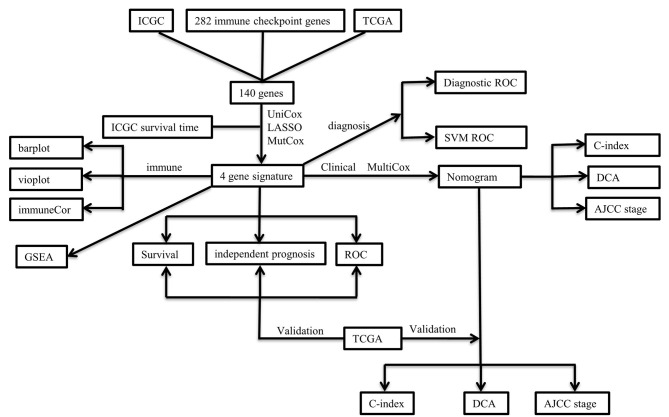
Flowchart of the research procedure in this study.